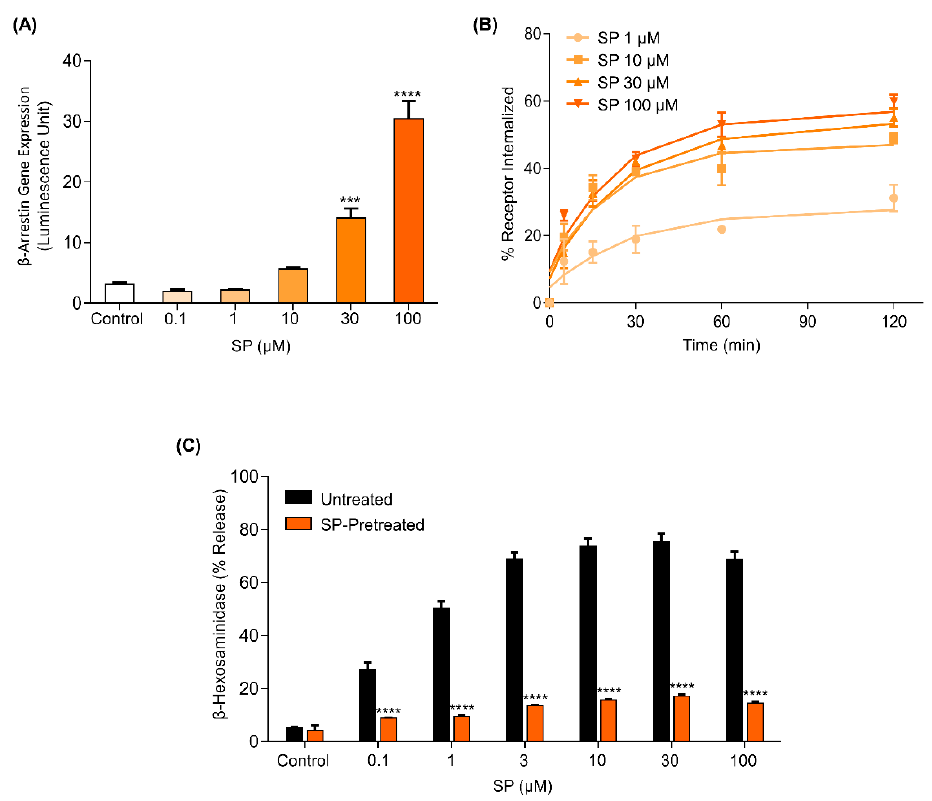
Figure 1. Substance P (SP) is a balanced agonist for MRGPRX2. ( A ) HTLA cells stably expressing MRGPRX2 (HTLA-MRGPRX2) were exposed to different concentrations of SP for 16 h, and β -arrestin–mediated gene expression was determined. ( B ) Rat basophilic leukemia (RBL) cells stably expressing MRGPRX2 (RBL-MRGPRX2) were stimulated with different concentrations of SP for the times indicated, and level of receptor internalization was determined by flow cytometry. ( C ) RBL-MRGPRX2 cells were cultured in the absence (untreated) or presence of SP (30 µ M) for 16 h. Cells were subsequently stimulated with different concentrations of SP for 30 min, and percent degranulation was determined by β -hexosaminidase release assay. All data points are the mean ± SEM of at least three experiments. For comparisons of two samples, two-tailed unpaired t -test was used. For comparisons of multiple samples to a control group, one–way analysis of variance (ANOVA) with Dunnett’s post-hoc test was used. *** p < 0.001 and **** p < 0.0001.